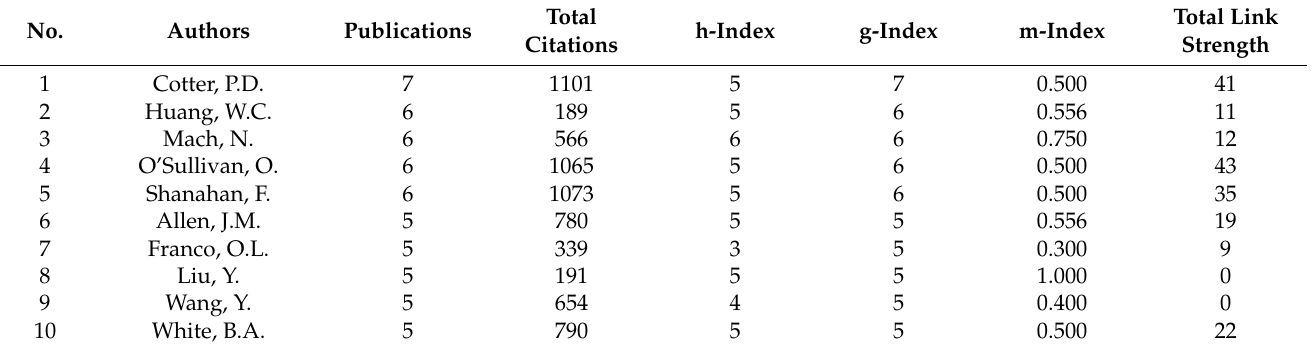
Table 3. Top ten active authors with the most publications about the gut microbiome and exercise.